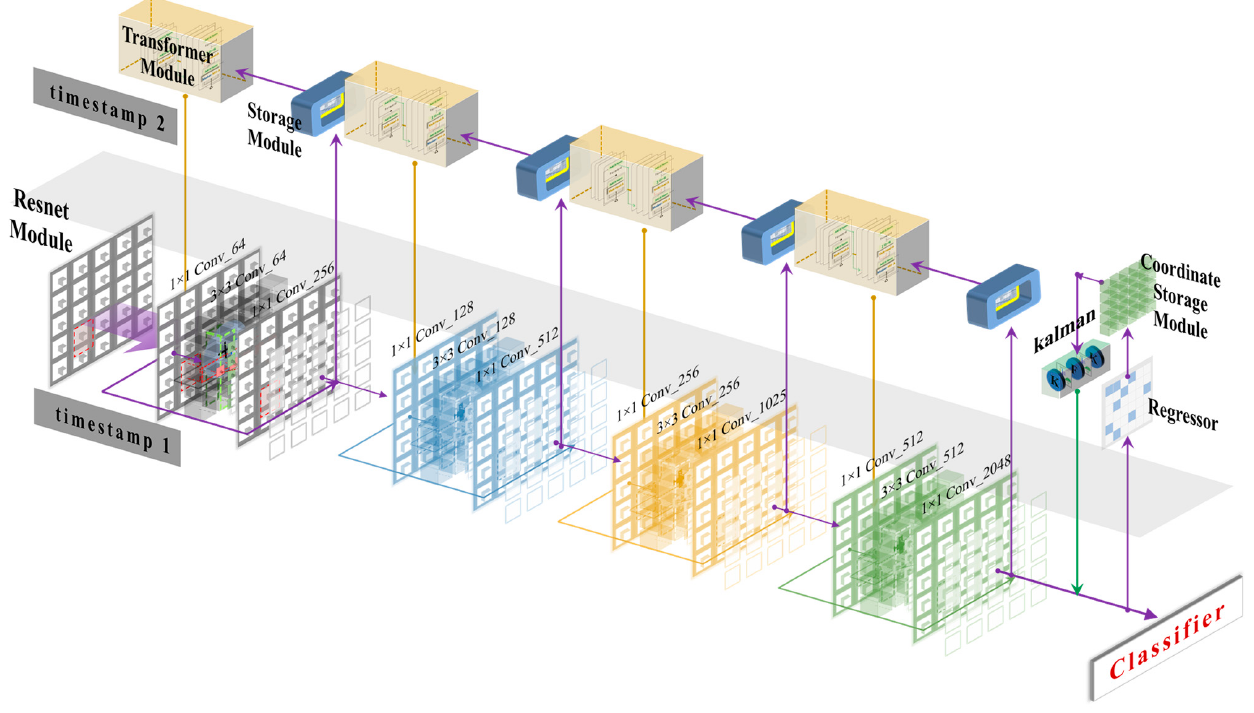
Figure 3. Temporal feature multiplexing network.